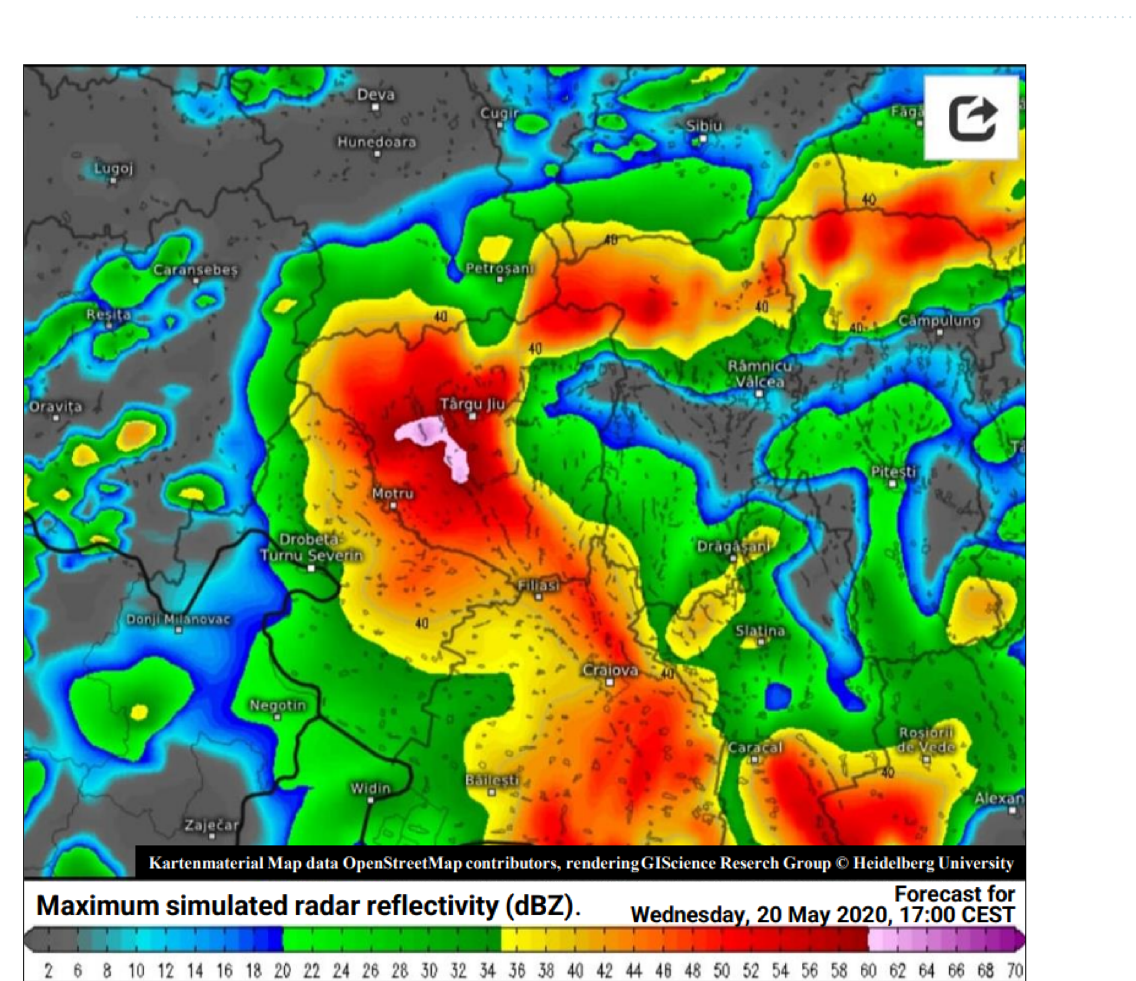
Figure 15. Map translated to English, showing Radar image acquired on 20/05/2020 at 17:00. Colors indicate simulated maximum radar reflectivity (dBz). Raster map 23.5 E, 44.9 N (zoom level 4 / resolution 400